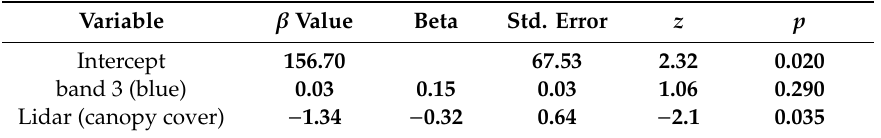
Table 4. Model parameters relating remote sensed variables to lichen biomass within jack pine forests in central Alberta, Canada. Variable name, beta-values ( β ), standardized beta (Beta), standard error (Std. Error), z value ( z ), and significance values ( p ) are provided. Band 3 refers to blue spectral values from KOMPSAT-3 imagery, while LiDAR refers to canopy cover derived from ALS.